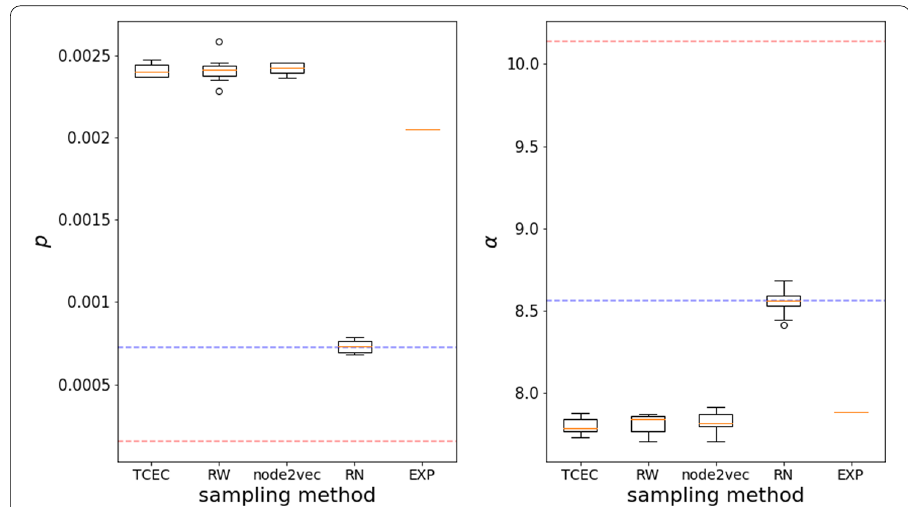
Fig. 6 Estimated parameters p , α for the ERGM network with reciprocity (Holland and Leinhardt 1981; Park and Newman 2004) after sampling with different algorithms. The red horizontal line represents the real network parameter, while the blue one its estimate re-fitted on the full generated network, to account for variability in generating the network from this probabilistic model. Box plots represent results across 10 rounds of